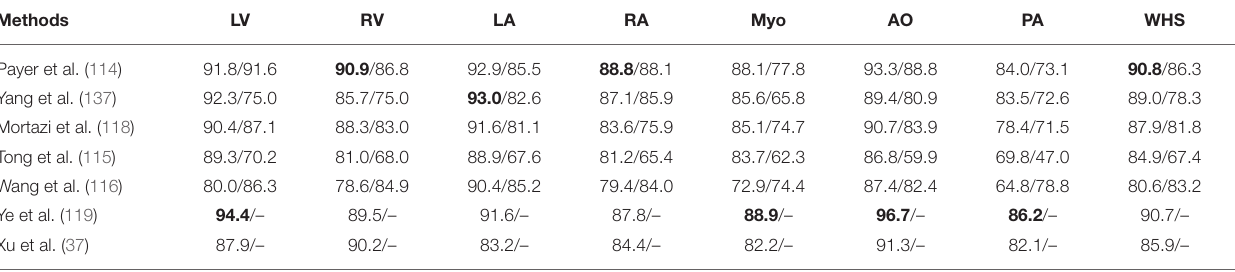
TABLE 4 | Segmentation accuracy of methods validated on MM-WHS dataset.